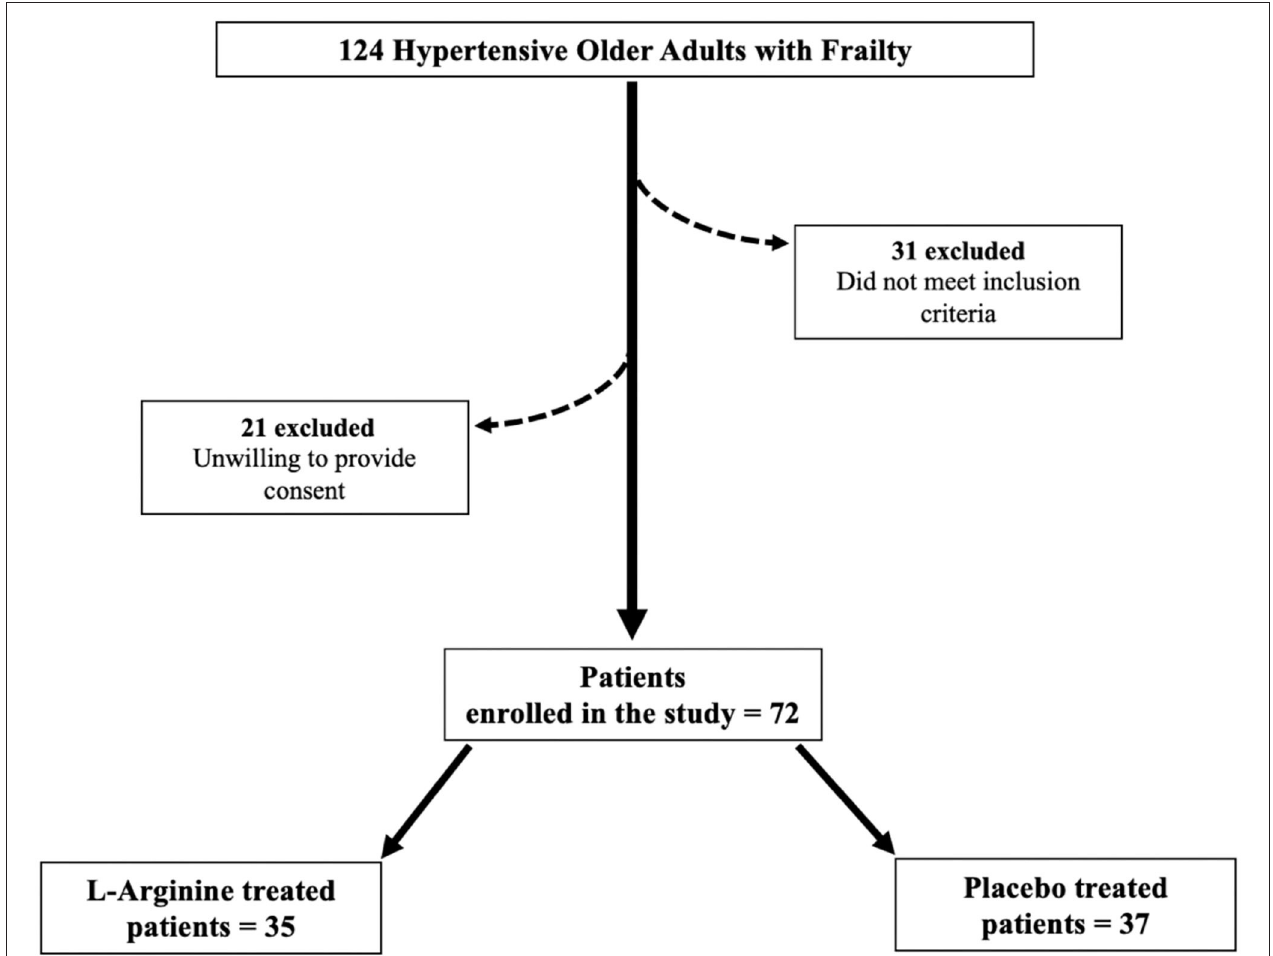
FIGURE 1 | Flow chart of the